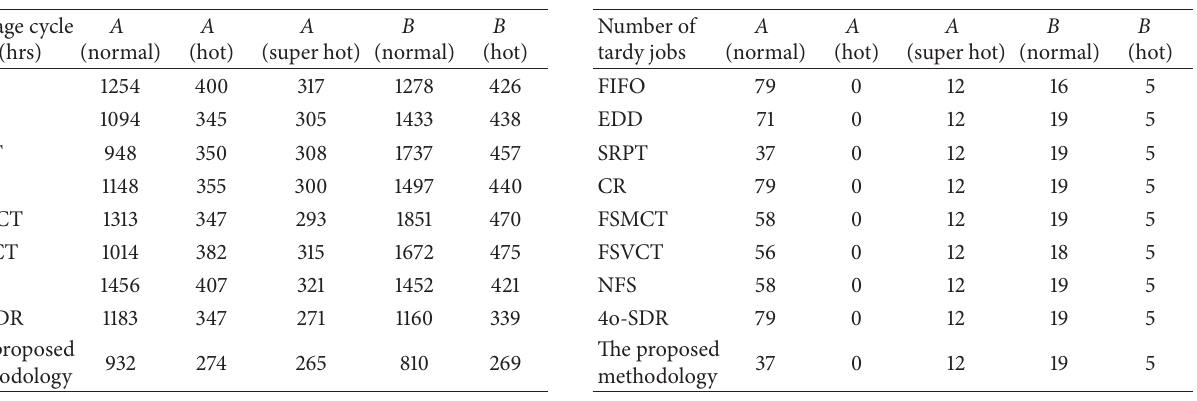
Table 4: The performance levels of various approaches for average cycle time.